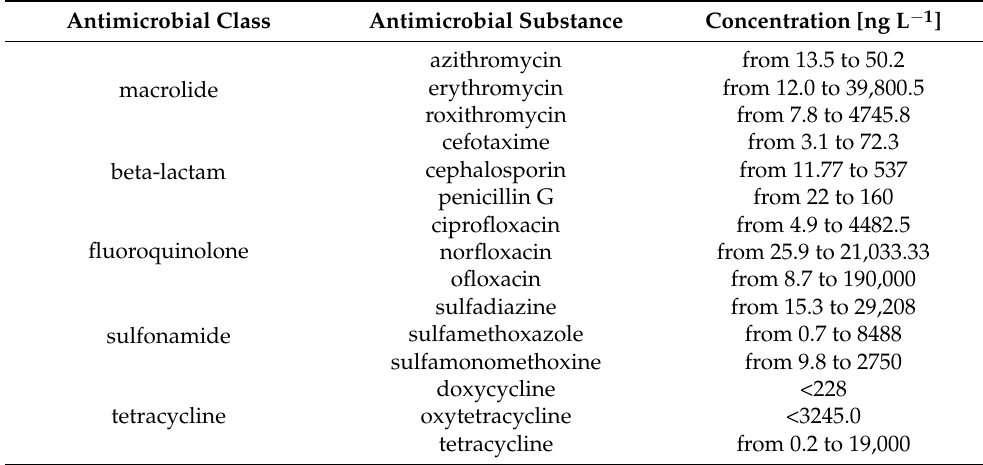
Table 6. Summary of antimicrobial substances and their concentration in landfill leachates, based on data collected by Yu et al. [122].